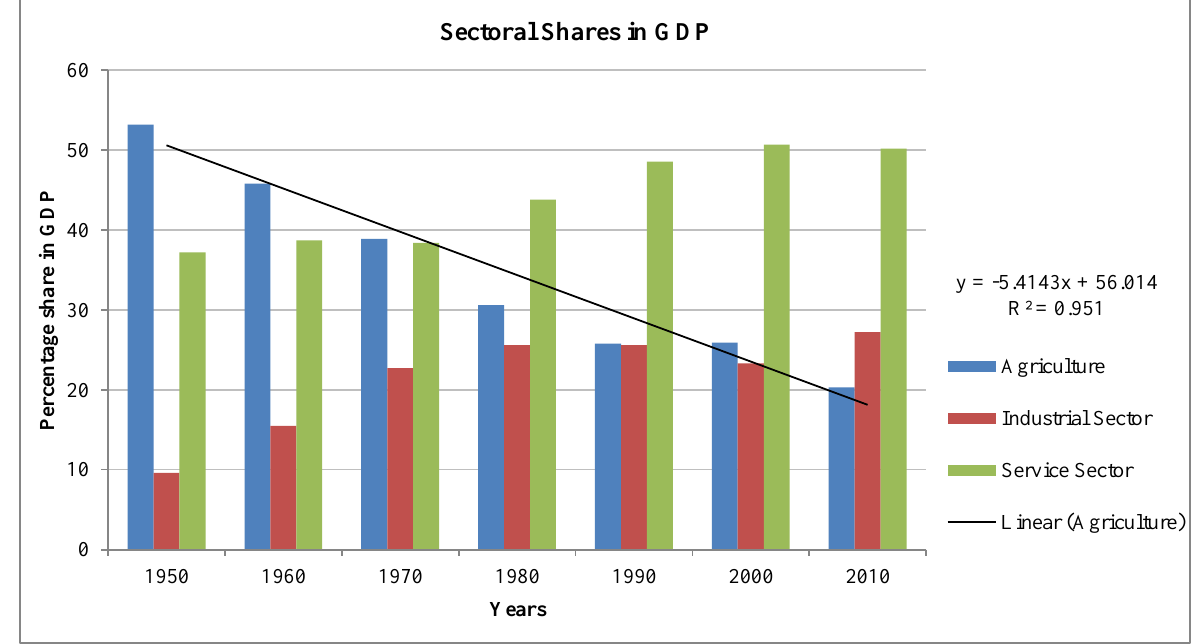
Figure 1. Sector wise Shares in GDP